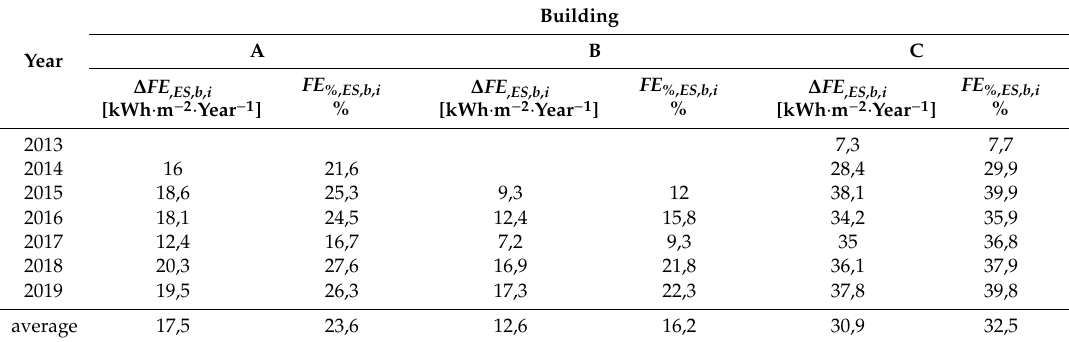
Table 6. The impact of the introduction weather controlled central heating system on the reduction of energy consumption in the building.